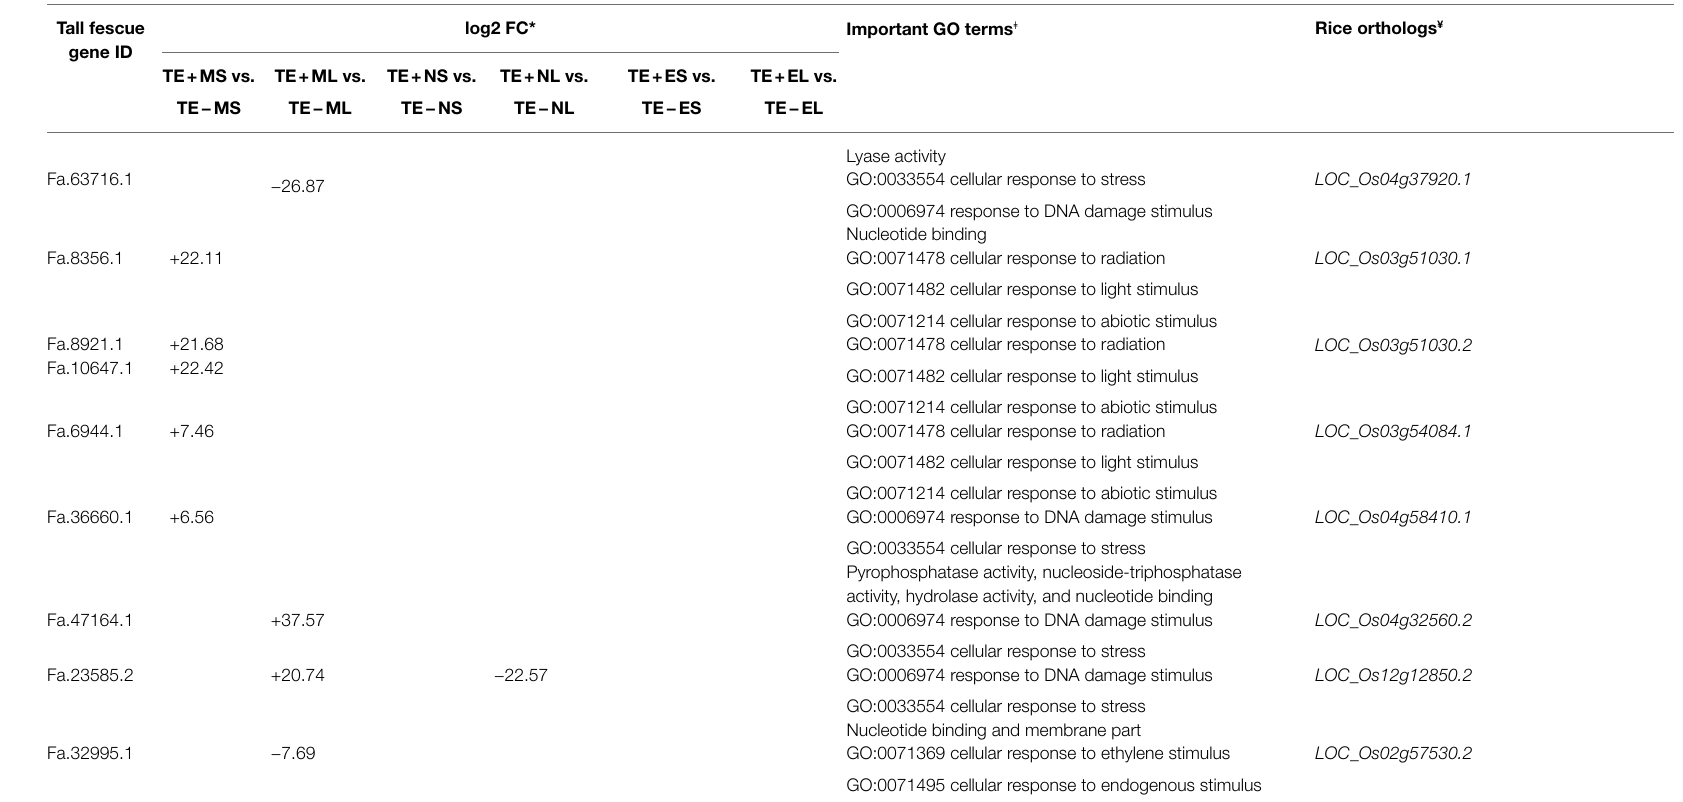
TABLE 2 | List of eight candidate genes in tall fescue expressed under freezing temperatures in the morning. Tall fescue gene